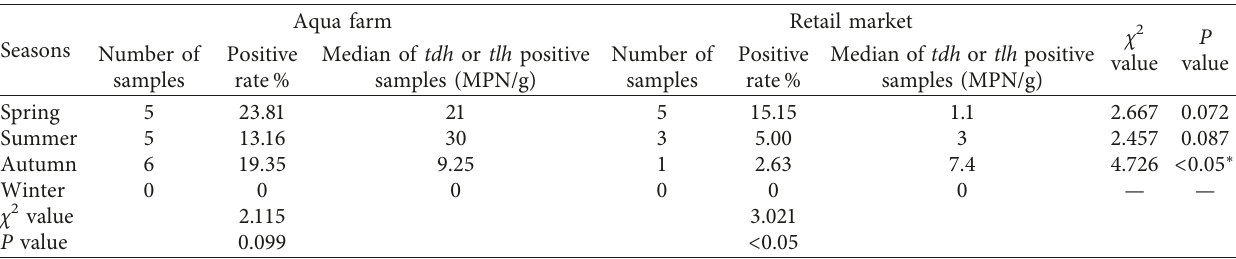
Table 7: Prevalence of contamination of pathogenic Vibrio parahaemolyticus in Anadara subcrenata among different seasons and markets.